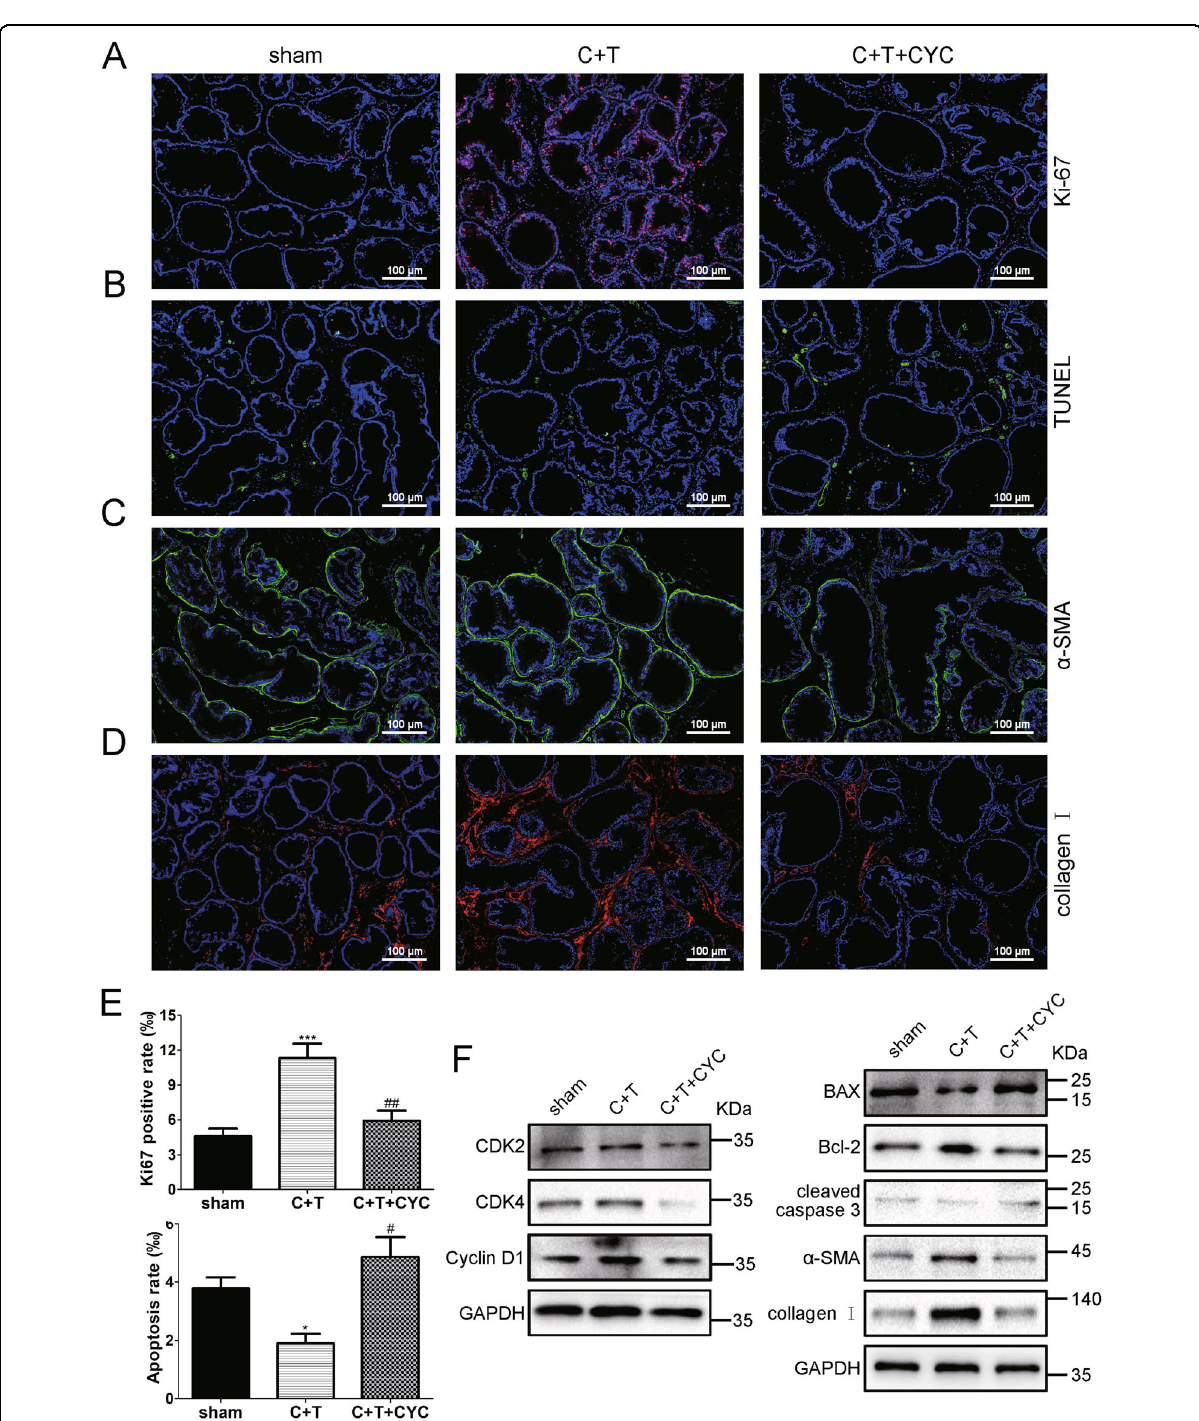
Fig. 7 CYC induced apoptosis and reduced tissue fi brosis markers in vivo. A The Ki-67 staining for the prostates from sham, BPH, and CYC- treated rats, respectively. DAPI (blue) and fl uorescence-labeled images (red) are merged. B The TUNEL staining for the prostates from sham, BPH, and CYC-treated rats, respectively. DAPI (blue) and fl uorescence-labeled images (green) are merged. C , D Representative the immuno fl uorescence staining of α -SMA and collagen I in prostate tissues from sham, BPH and CYC-treated rats. DAPI (blue) indicates nuclear staining, Cy3 immuno fl uorescence (red) indicates collagen I protein, Cy3-immuno fl uorescence (green) indicates the α -SMA protein, and merged images were shown. E The bar graph for Ki-67-positive rate (%) and apoptosis rate (%) of TUNEL-positive cells. F Immunoblot assay of cyclin D1, CDK2, CDK4, BAX, Bcl-2, cleaved caspase-3, α -SMA, and collagen I in sham, BPH, and CYC-treated rats. * p < 0.05 BPH vs sham, *** p < 0.001. BPH vs sham. # p < 0.05 CYC vs BPH, ## p < 0.01 CYC vs BPH. One-way ANOVA. The scale bars are 100 μ